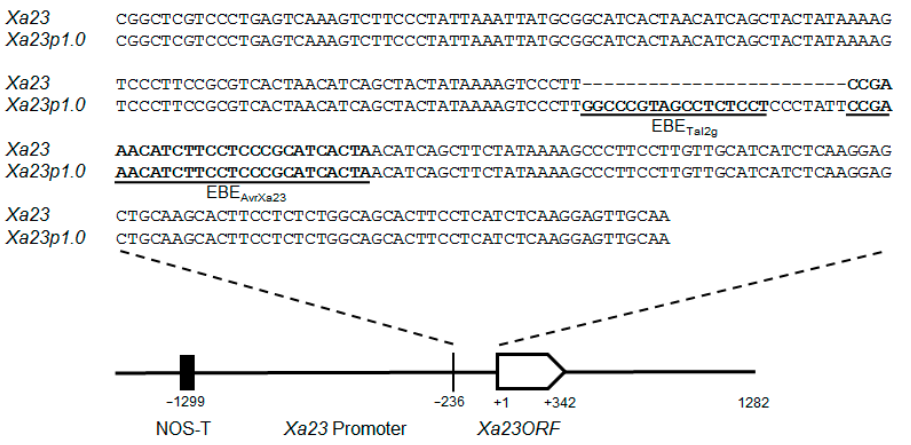
Figure 1. Schematic map and nucleotide sequences of generated Xa23p1.0 . A 2.5 kb fragment containing the Xa23 locus was modified by inserting the 17 bp EBE Tal2g and linker sequence CCCTAT into the promoter region via Gibson cloning.